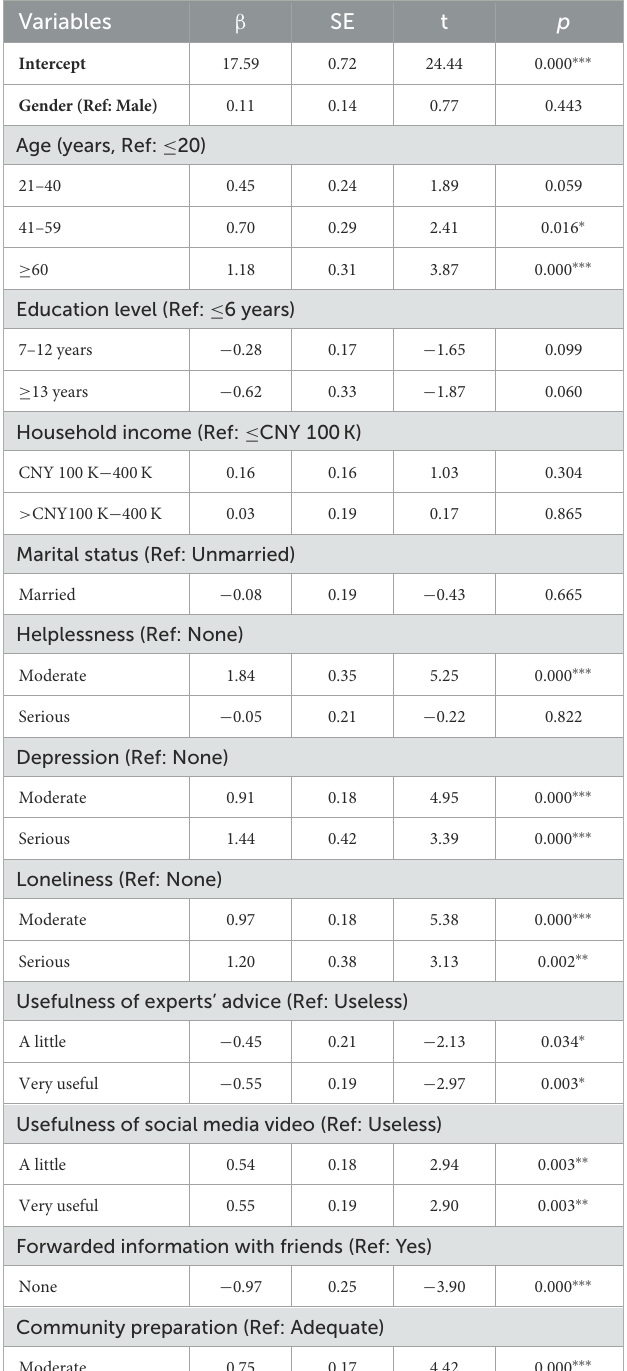
TABLE 2 Multiple regression results of risk